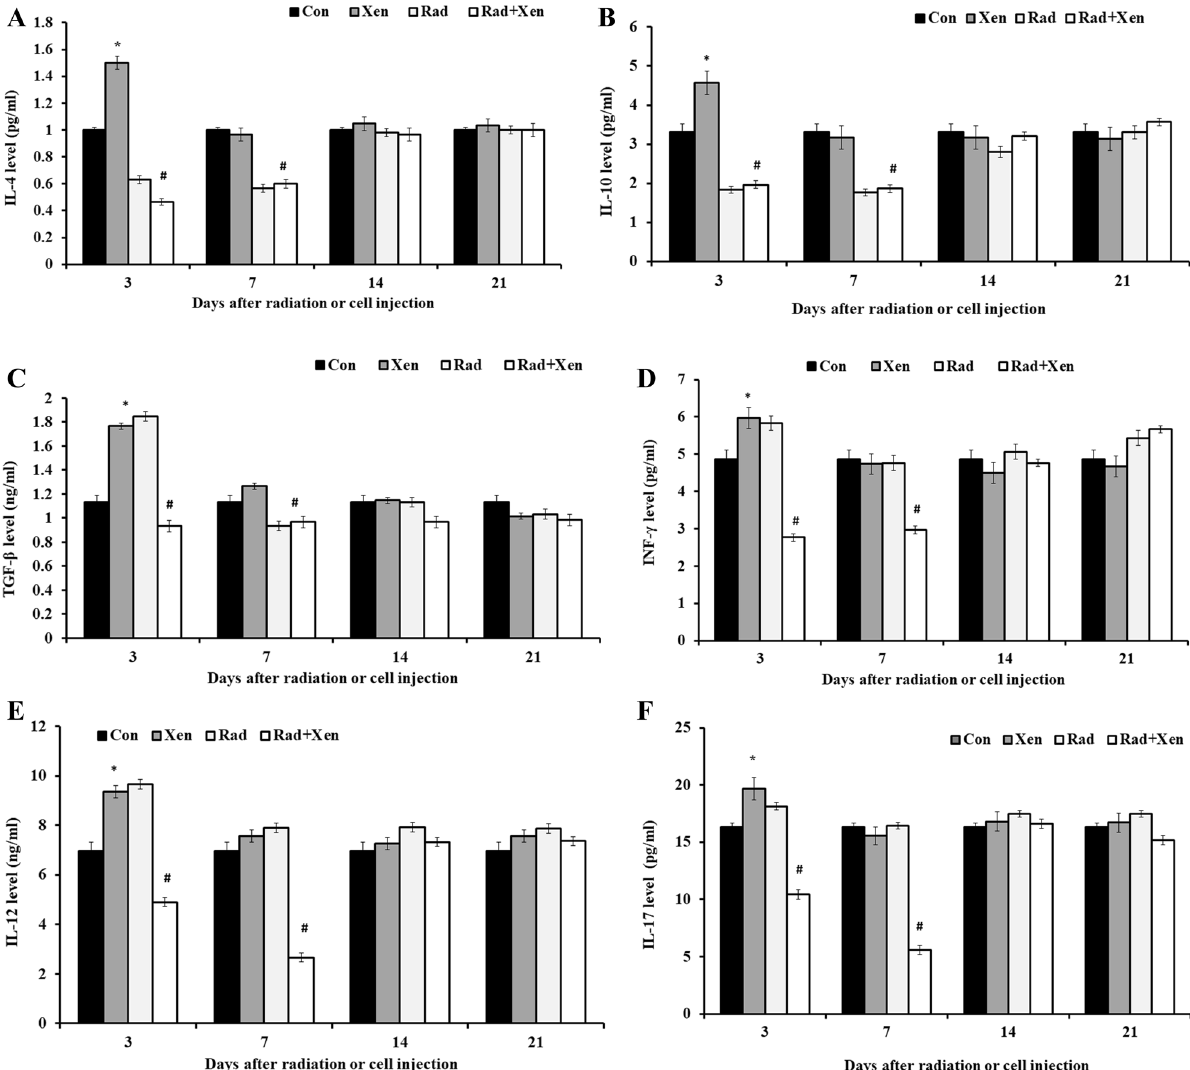
Figure 3. The spleen levels of IL-4 (A), IL-10 (B), TGF-β (C), INF-γ (D), IL-12 (E), and IL-17 (F) on 3, 7, 14, and 21 days after gamma radiation in mice. Con: control, Xen: cell injection group, Rad: gamma radiation group, and Xen + Rad: gamma radiation plus cell injection group. Data were reported as mean ± SD. *P ≤ 0.05 compared to the control group, # P ≤ 0.05 compared to the Xen trol group and the Xen + Rad group vs. the Xen alone. The cytokine levels of the spleen, including IL-4 (Fig. 3A) and IL-10 (Fig. 3B), were significantly increased in the Xen alone group compared to the control group on the 3rd day (P ≤ 0.05). However, their levels were not meaningfully different between the control and Xen groups on 7, 14, and 21 days. The spleen level of IL-4 and IL-10 was considerably increased in the Xen + Rad than the Xen alone group on 3 and 7 days (P ≤ 0.05). However, their levels were not meaningfully different between the Xen alone and Xen + Rad groups on 14 and 21 days. The cytokine levels of the spleen, including TGF-β (Fig. 3C), INF-γ (Fig. 3D), IL-12 (Fig. 3E), and IL-17 (Fig. 3F), were significantly increased in the Xen alone group compared to the control group on the 3rd day (P ≤ 0.05). However, their levels were not meaningfully different between the Xen alone and control groups on 7, 14, and 21 days. The spleen’s cytokine levels, including TGF-β, INF-γ, IL-12, and IL-17, were dramatically decreased in the Xen + Rad group compared to the Xen alone group on 3 and 7 days (P ≤ 0.05). However, their lev- els were not meaningfully different between the Xen + Rad and Xen alone groups at 14 and 21 days after radiation. The results of the gene expression. The expression level of genes, including GATA-3, T-Bet, ROR-γt, VEGF, Foxp3, Ki67, Bax, and Bcl-2, was determined by the quantitative real-time PCR on 3, 7, 14, and 21 days post-radiation or cell injection (Fig. 4A–G). The mRNA’s spleen expression has been compared in the Xen alone vs. the control group and the Xen + Rad group vs. the Xen alone. The spleen expression of the Foxp3 (Fig. 4A) was significantly decreased in the Xen group compared to the control group on the 3rd day after cell injection